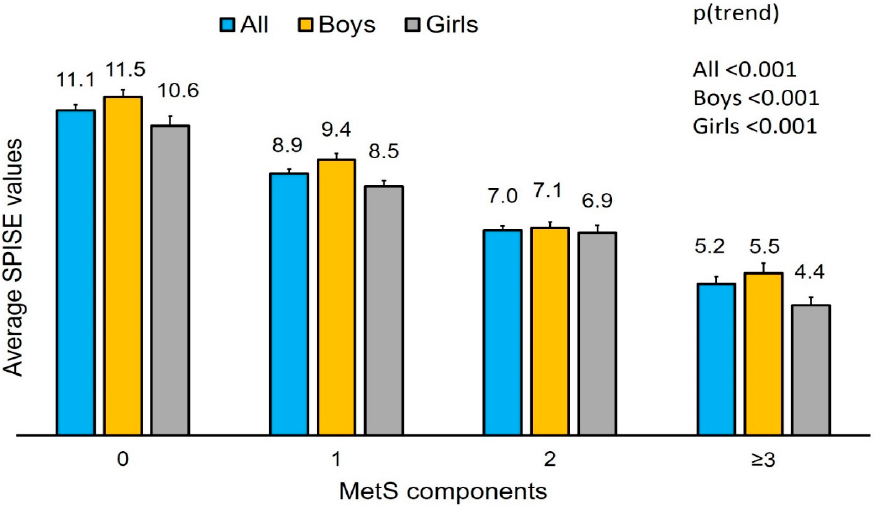
Figure 1. Average SPISE values for subjects with different MetS components.